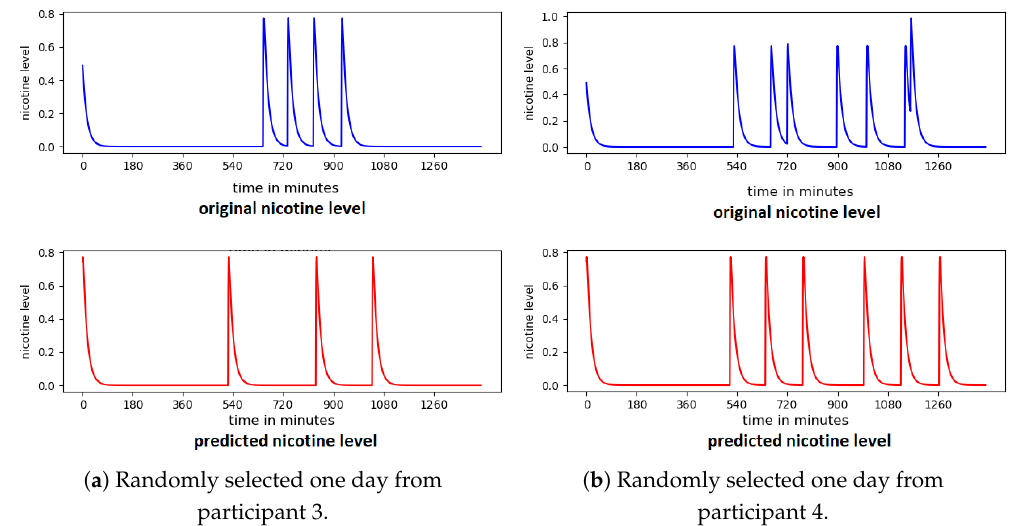
Figure 13. Predicted nicotine level for participants with a high presence of app-off values.